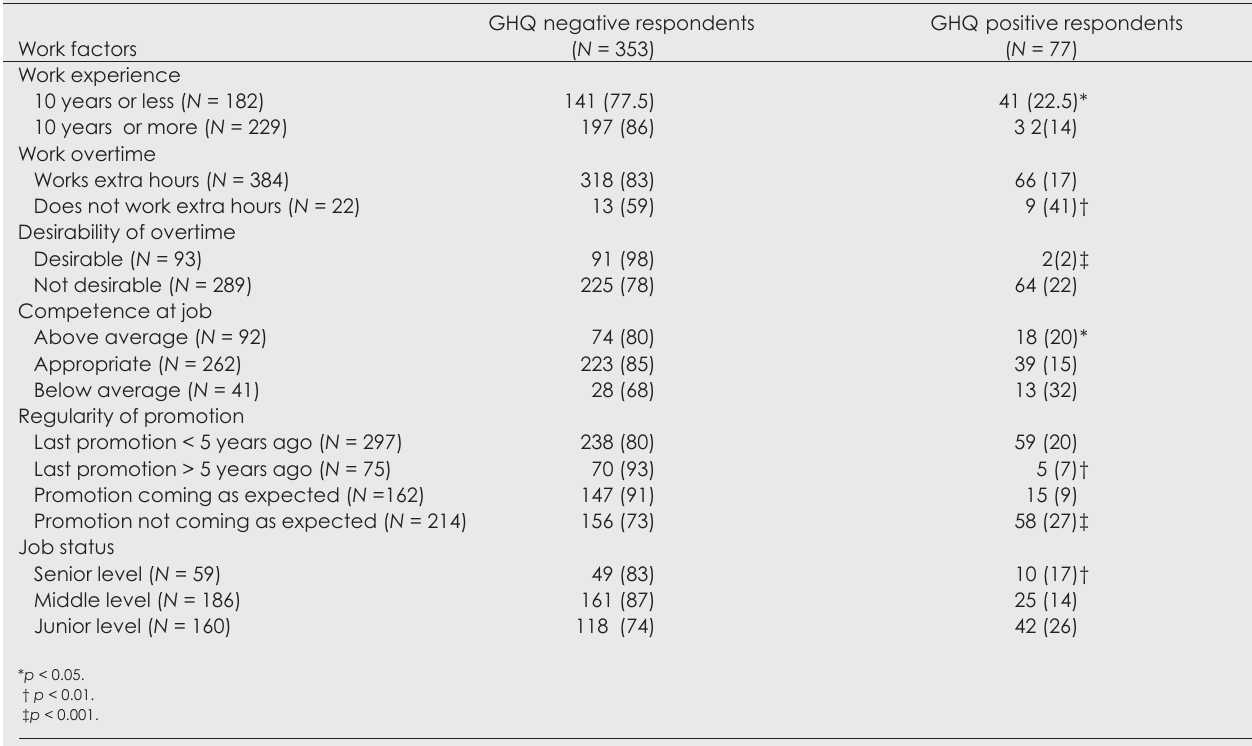
Table II. Psychosocial factors at work of respondents ( N